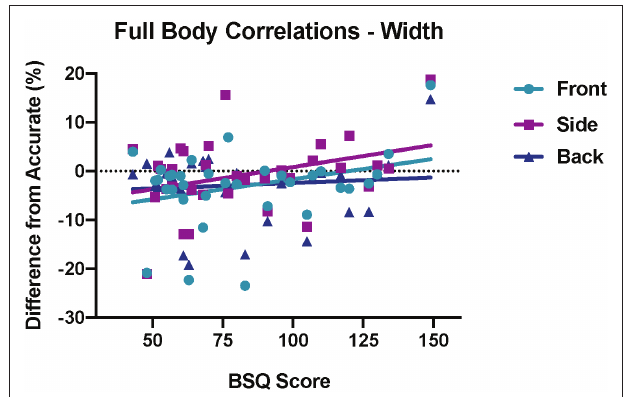
FIGURE 5 | Correlations between BSQ score and differences from accurate for perceived body width for the front (blue circles), side (purple squares), and back (dark blue triangles) viewpoints ( n = 34). The solid lines through the data represent linear regression